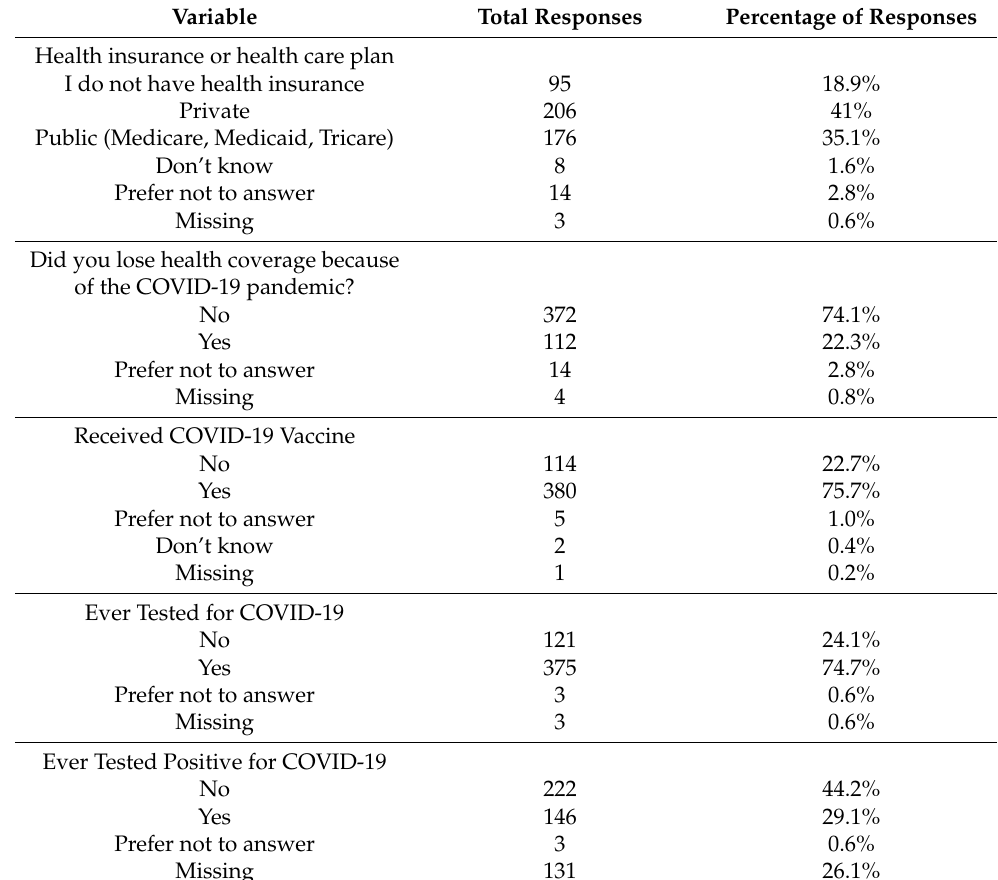
Table 2. Background information ( N =